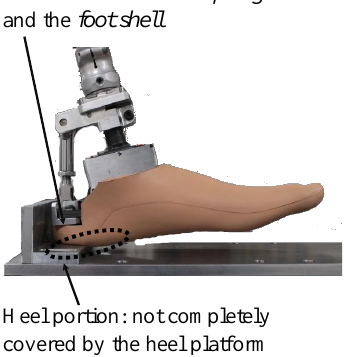
Figure 27. Plantarflexion test: the heel of the foot shell was not completely covered by the platform. The plantarflexion displacement–reaction force curve obtained from the 3D FEA resulted stiffer than the curve obtained from the mechanical test after around 6–7 mm of the vertical displacement of the platform. After 6–7 mm of vertical displacement, the heel was